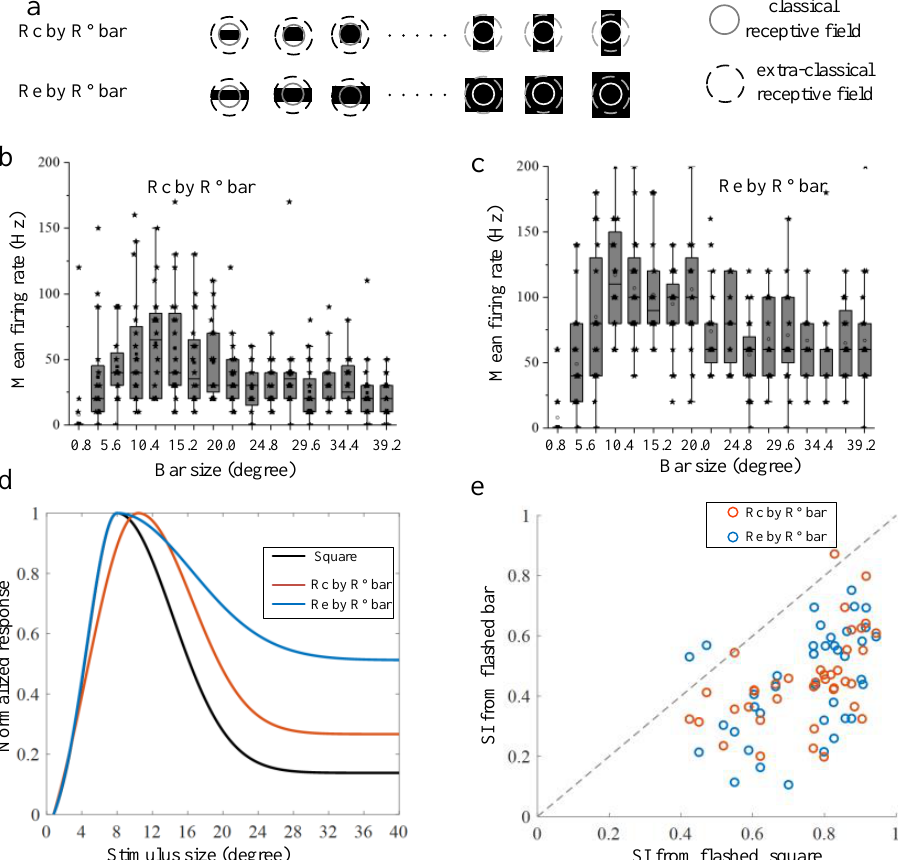
Figure 3. Summarized results of surround suppression induced by flashed bars and the statistical comparison with that by flashed squares. ( a ) Two groups of bars. One kept the fixed side length at R c (R c is the diameters of classical receptive field, upper), and another was set to R e (R e is the diameters of extra-classical receptive field, lower). The varying size lengths (indicated with R in ( b – e )) were the same level of squares from 1 to 4 degrees. The solid line circle in each subfigure indicates the classical receptive field area and the dotted circle indicates the extra classical receptive field area, which is the same as in Figure 4a. The black square in each subfigure denotes varying lengths of flashed bars. ( b , c ) The mean firing rates of 20 repeats at an example recording site under each stim- ulus shown in ( a ); the horizontal line indicates the median of each group of data and the whiskers indicate the lowest and highest point within 1.5× of the interquartile ranges of the lower or upper quartile, respectively. Each black asterisk represents firing rates of a single trial. ( d ) The normalized fitted size-tuning curves under each stimulus shown in ( a ) (red: adjust-R 2 = 0.9049, ascending limb; adjust-R 2 = 0.8737, descending limb; blue: adjust-R 2 = 0.9796, ascending limb; adjust-R 2 = 0.8354, de- scending limb) as well as in Figure 2a (black: adjust-R 2 = 0.9462, ascending limb; adjust-R 2 = 0.8628, descending limb); ( e ) the suppression index for flashed square stimulus versus two groups of the flashed bars. Each dot represents SI from a single recording site. Red symbols show SIs of R c by R bar, and blue of R e by R bar. The diagonal line displays the locus of equal value.